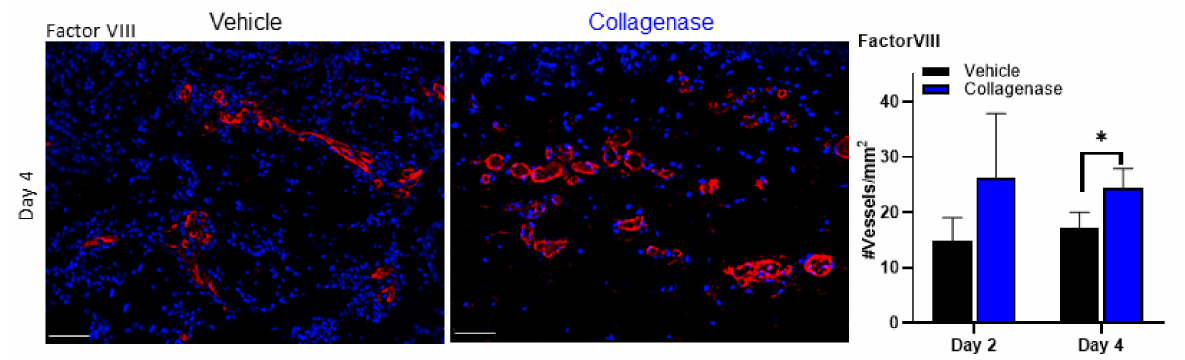
Figure 4. Collagenase-treated burns show blood vessel preservation. Factor VIII expression and blood vessel quantification in porcine burn interspaces in wounds treated with vehicle and collagenase hydrogels. Factor VIII expression in the wound interspace sections on day 4 show treatment with collagenase has significantly greater factor VIII expression, which translated to significantly greater blood vessel quantification per tissue area for collagenase-treated wounds. White scale bars represent 50 µ m. Number of vessels/mm 2 was calculated from the total number of vessels/total area in mm 2 as visualized by anti-factor VIII stain. Values represent mean of 4 biopsies per time point and per treatment ( n = 4) ± SD. * p <